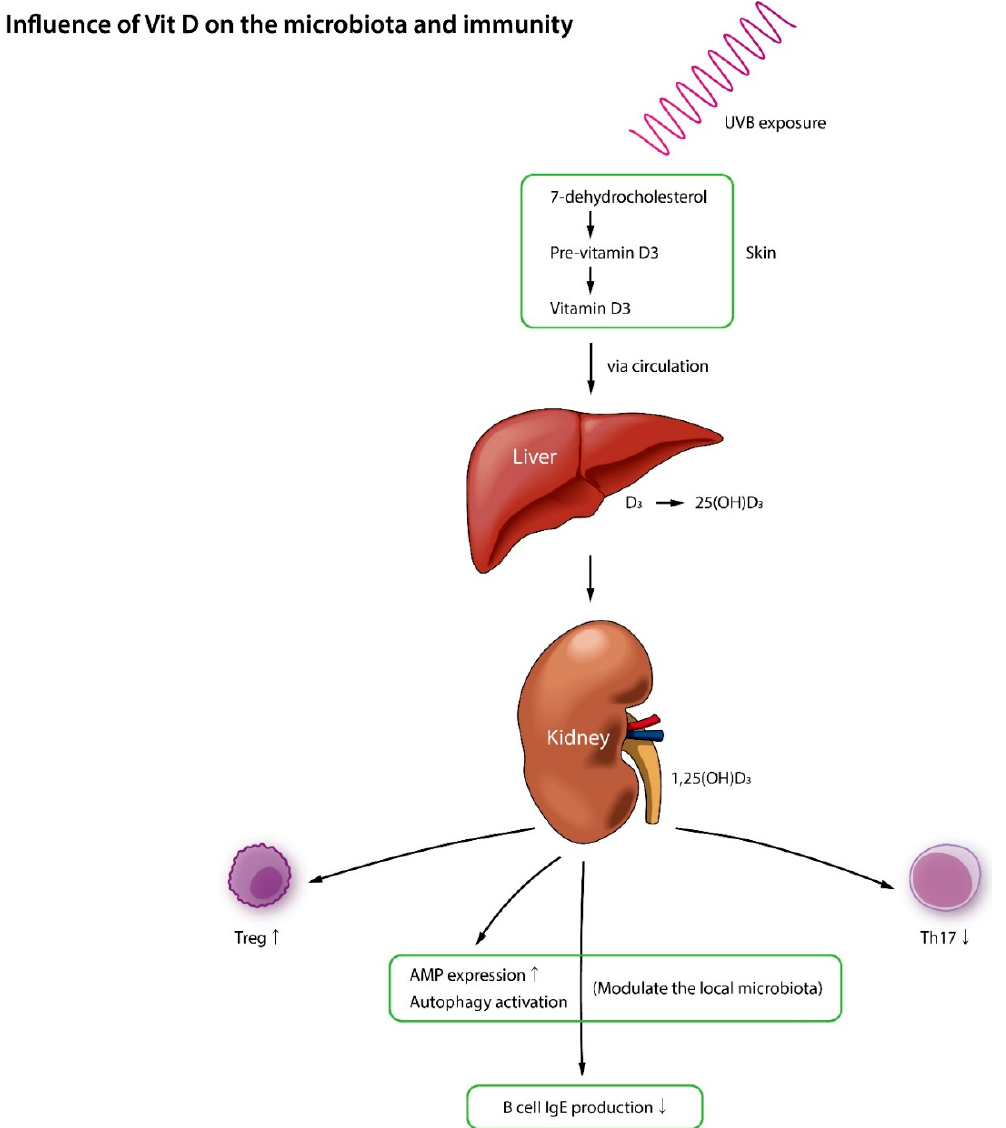
Figure 5. Vitamin D controls autophagy and the production of antimicrobial peptides which can help normalize the microbiota. It also regulates innate and adaptive immunity in various ways.